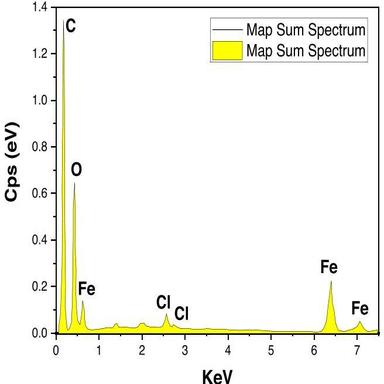
EDS spectrum of the Fe-BDC-DMF powder.